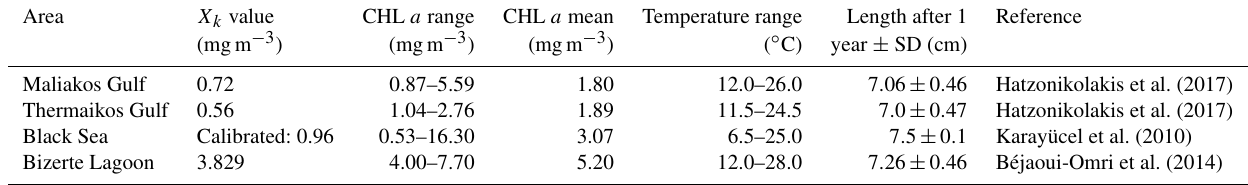
Table 4. Half-saturation tuned values ( X k ) and mussel growth data (length) in different areas of the Mediterranean and Black seas. Area X k value CHL a range CHL a mean Temperature range Length after 1